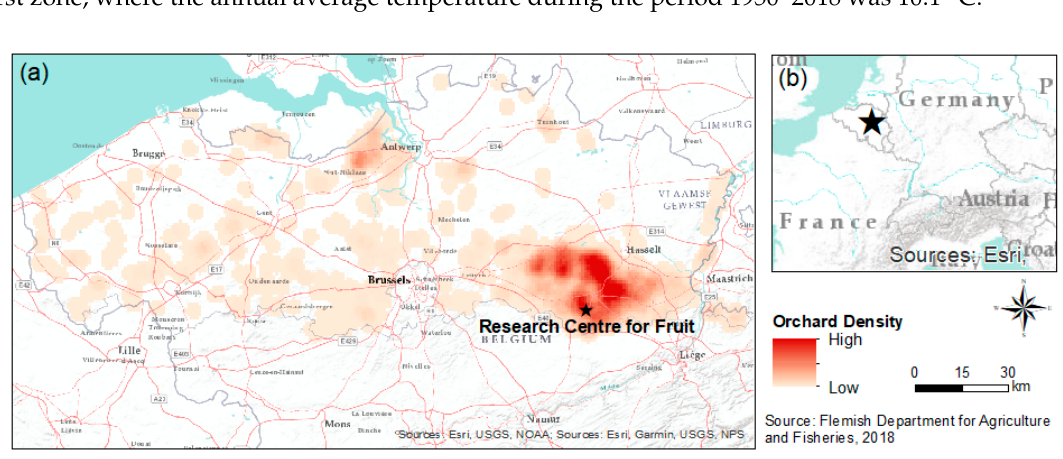
Figure 1. Distribution of apple and pear orchards in the Flemish Region, Belgium ( a ), with locator map ( b ). The star marks the study site, the Research Centre for fruit (50°46 ′ N, 5°09 ′ E, 92 m above sea level).